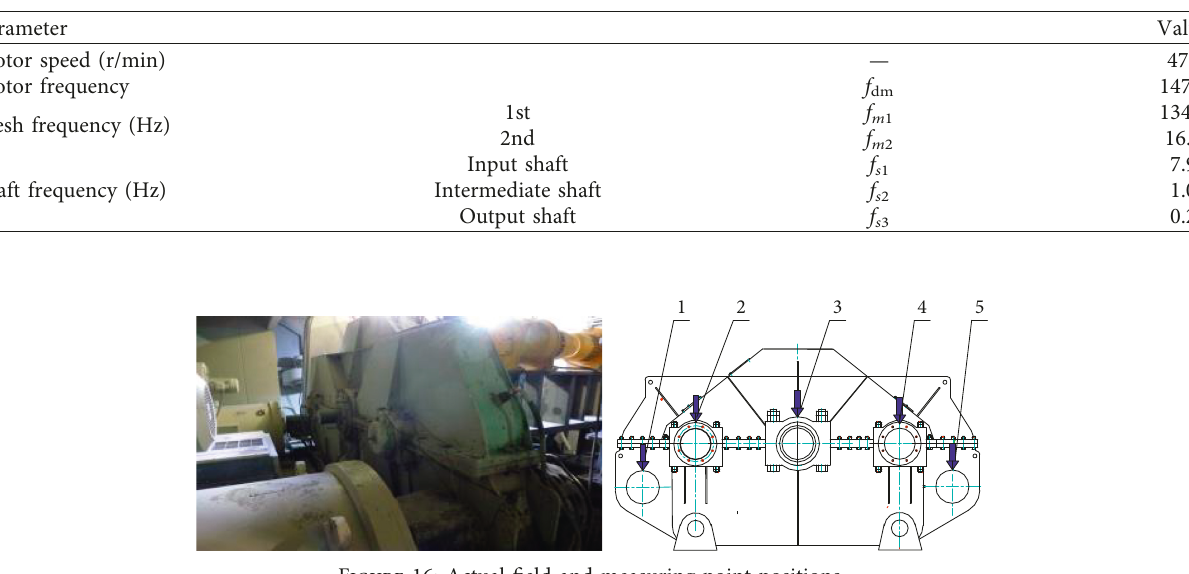
Table 6: Excitation frequency of gear subsystem and motor.